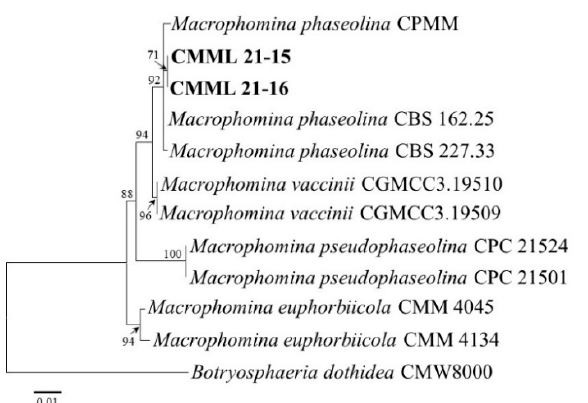
Figure 6. Maximum likelihood tree of the Macrophomina isolates (CMML21–15 and CMML21–16) inferred from the combined data sets of the ITS and EF1– α gene sequences constructed by the MEGA X program. The tree is rooted to Botryosphaeria dothidea CMW8000. Numbers on the branches indicate the bootstrap values. The scale bar indicates expected changes per site. The isolates from the present study are indicated in bold.